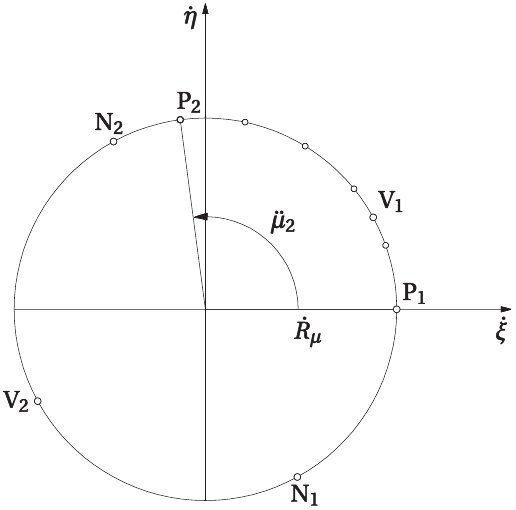
Figure 6. Rotated equidistant circumference that represents the elliptical section of Figure 3. Between 1 P and 2 P , four waypoints are marked at equidistant